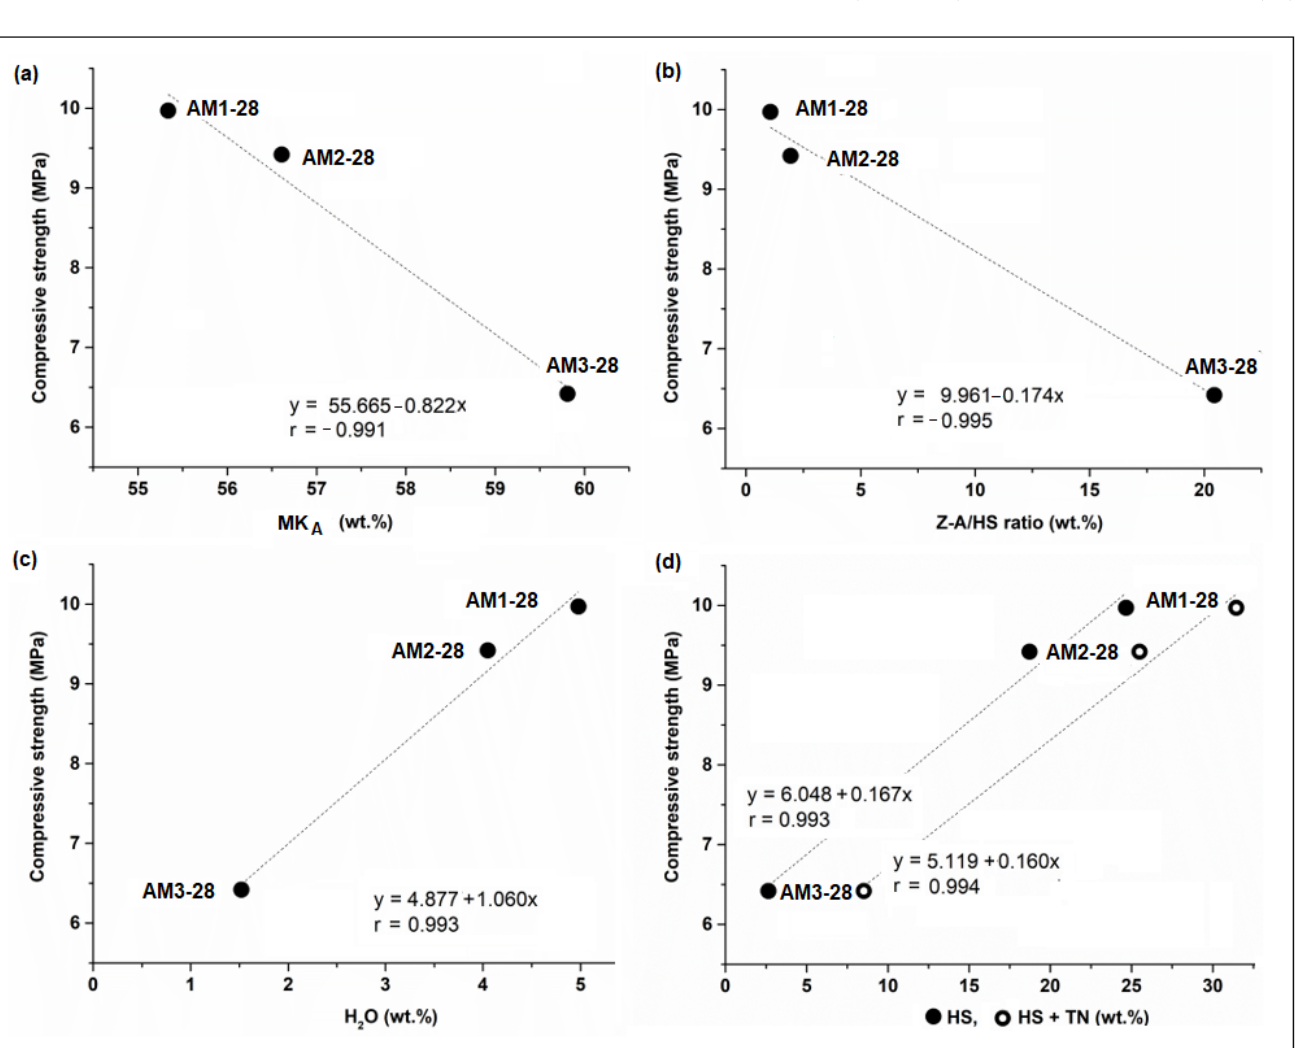
Figure 9. Compressive strength of AM-28 metakaolins in relation to wt.% (a) MK A ; (b) Z-A/HS; (c) H 2 O; and (d) HS and HS + TN.